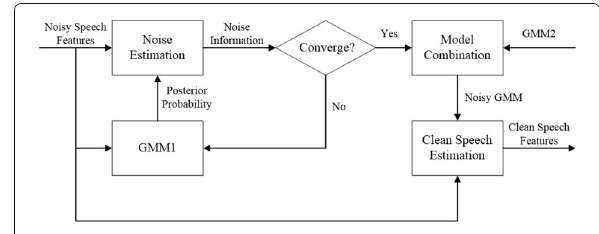
Fig. 1 The proposed feature compensation